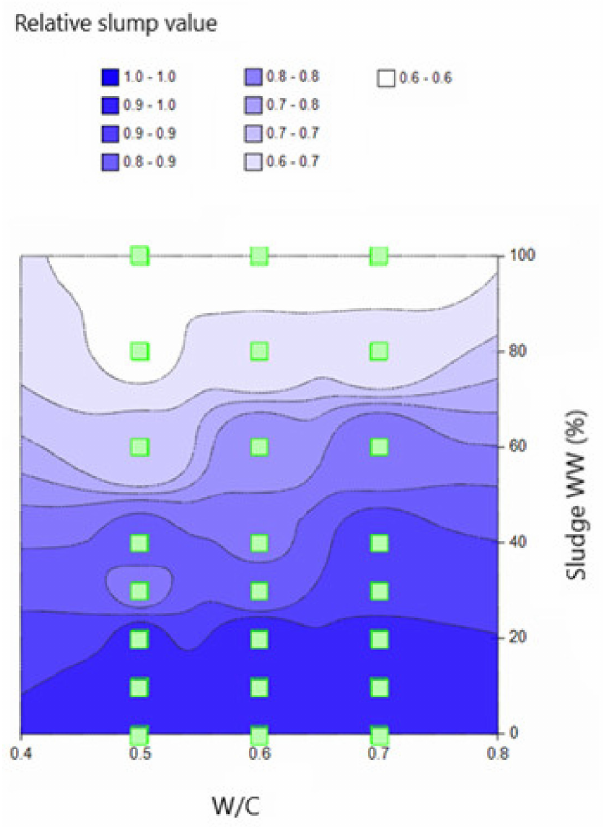
Figure 3. Effect of different incorporation ratios of WW on the slump of concrete made with various w/c.